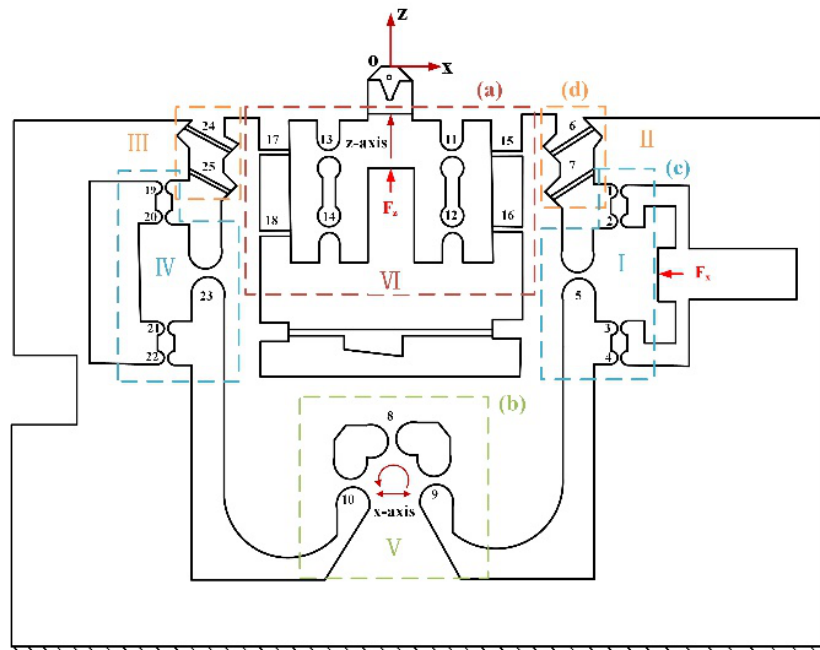
Figure 2. Schematic of the designed 2-DOF FTS.